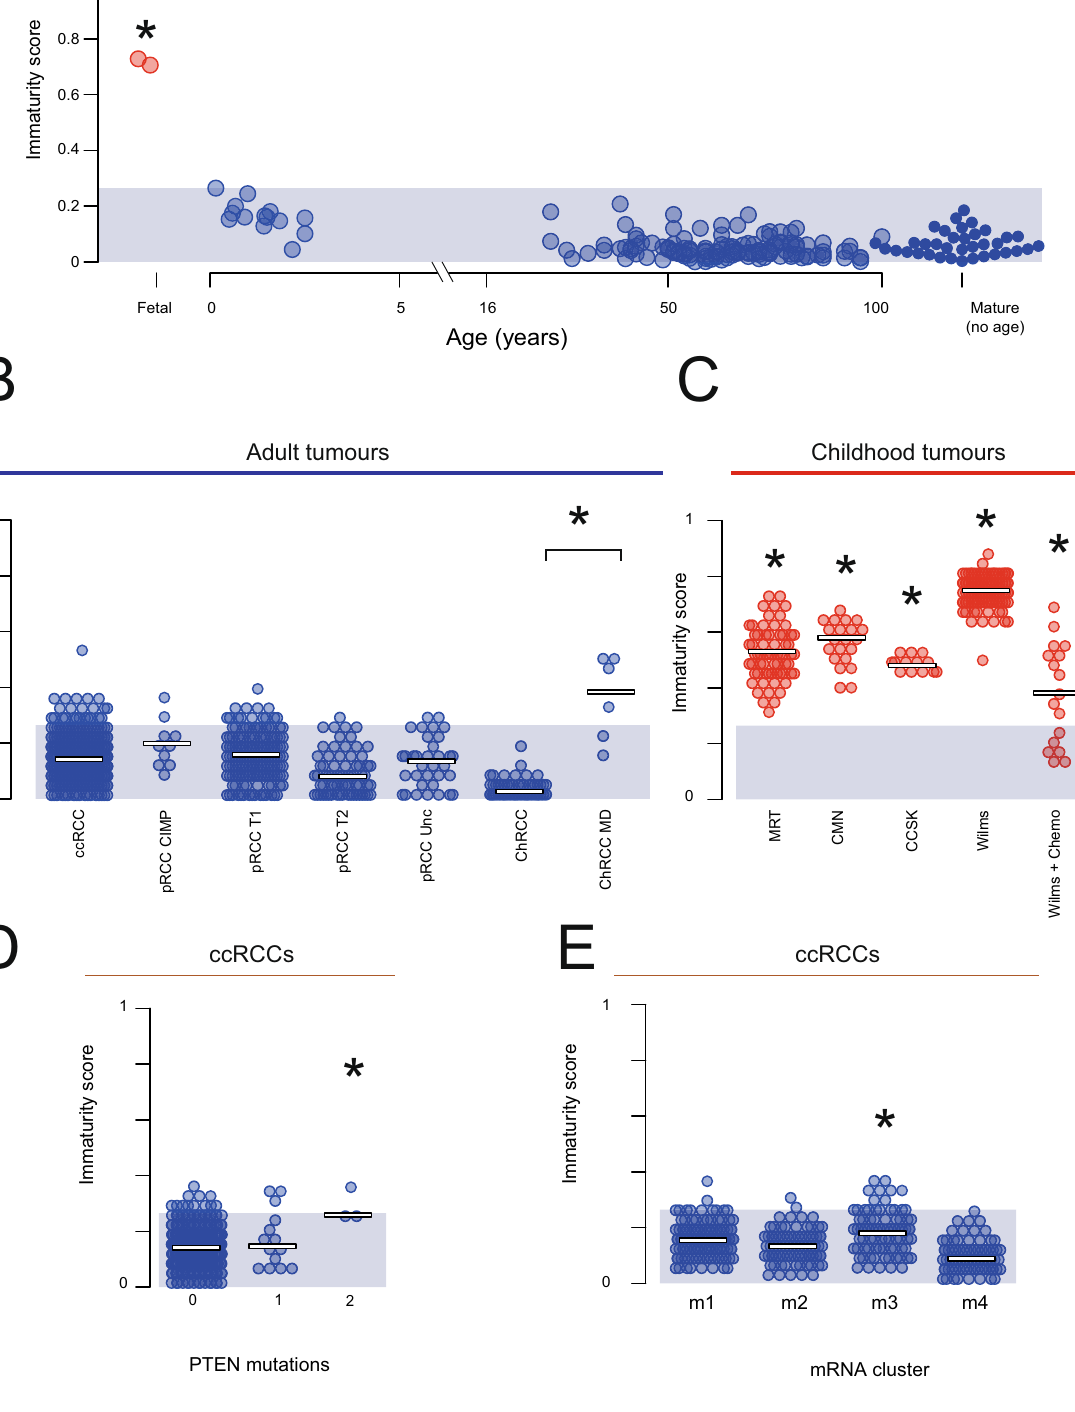
We annotated single cells based on literature derived marker genes (Fig. 3D, S5) and compared to single cell clusters of normal fetal kidneys using previously developed quantitative approaches 1 . This comparison revealed that CMN tumor cells matched the same mesenchymal progenitor cell population, validating the cell signal seen in bulk tumor tissue (Fig. 3E).